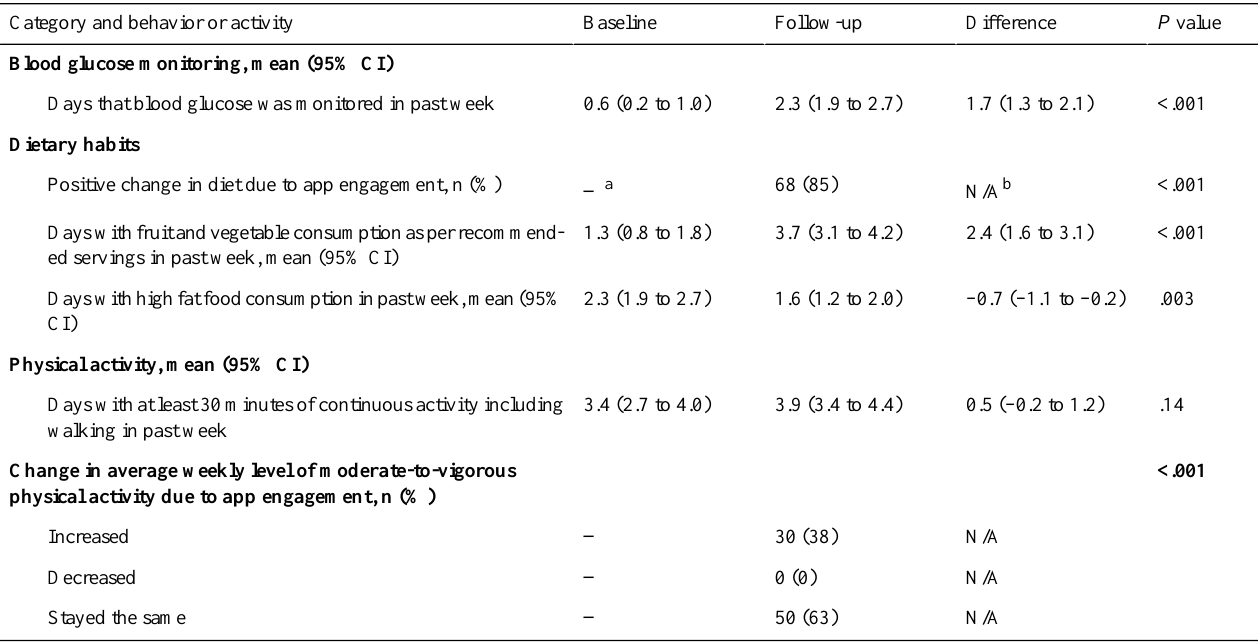
P valueDifferenceFollow-upBaselineCategory and behavior or activity